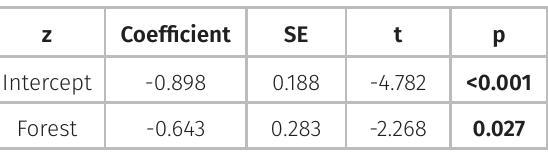
Table IV. Statistical results (coefficient estimates, standard error [SE], t value, and p-value) for the best model selected to explain roadkill events of Squamata in the protected landscape in Alto Paraíso de Goiás, Goiás state, Brazil. Significant values at ɑ<0.05 are in